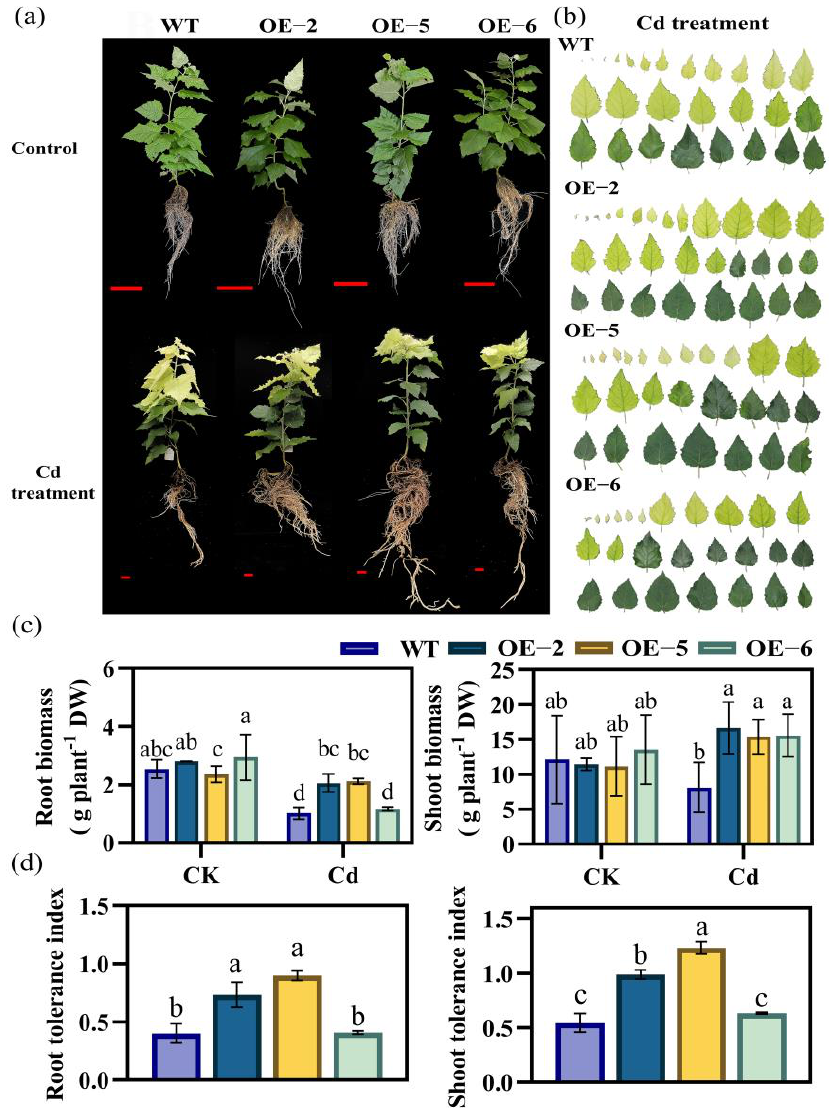
Figure 1. Phenotypes of SpHsfA4c in transgenic P. × canescens , and wild-type poplars (WT). ( a ) Phe- notypes of the SpHsfA4c- transgenic lines ( SpHsfA4c- OE−2, SpHsfA4c- OE−5, SpHsfA4c- OE−6) and WT with or without 100 µ M CdCl 2 for 30 d; ( b ) comparison of leaf color between transgenic poplars and WT under Cd stress; ( c ) dry weight; ( d ) tolerance indexes (TIs). CK: 0 µ M CdCl 2 treatment; Cd: 100 µ M CdCl 2 treatment. Data are presented as means ± SD, different letters above the bars represent significant differences at p <